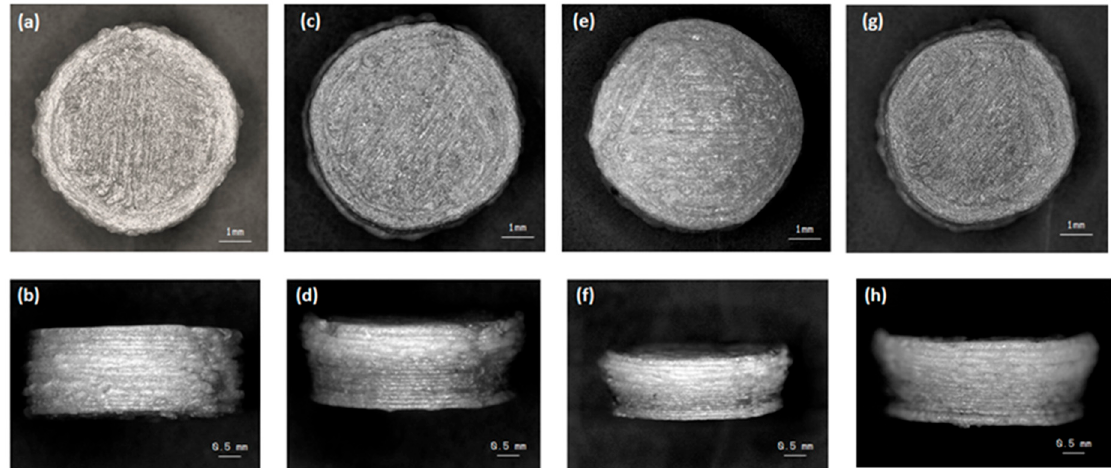
Figure 4. SEM micrographs of 3D printed captopril tablets with top and side view ( a , b ) F1, ( c , d ) F2, ( e , f ) F3, and ( g , h )